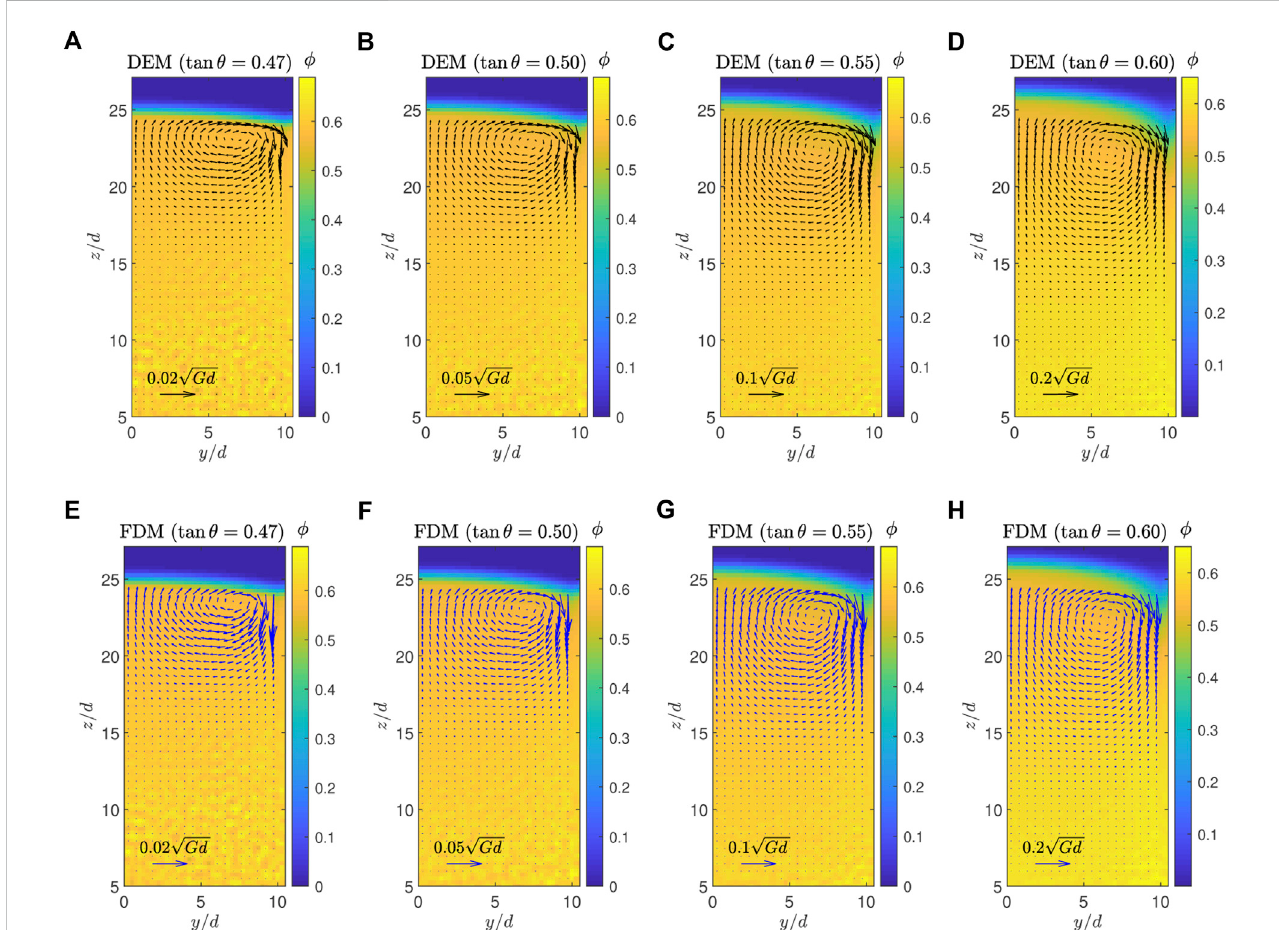
FIGURE 11 TransversevelocitycomparisonbetweentheDEMsimulations (A – D) andtheFDMsimulationsusingthesecond-ordermodel (E – H) : (A) DEMwithtan θ = 0.47, (E) FDM with tan θ = 0.47, (B) DEM with tan θ = 0.50, (F) FDM with tan θ = 0.50, (C) DEM with tan θ = 0.55, (G) FDM with tan θ = 0.55, (D) DEM with tan θ = 0.60,and (H) FDMwithtan θ =0.60.Arrowsindicate( v y , v z )andtheirlengthscalesaredisplayedatthebottomofthe fi gures.Packingfractionisshownascolor in the